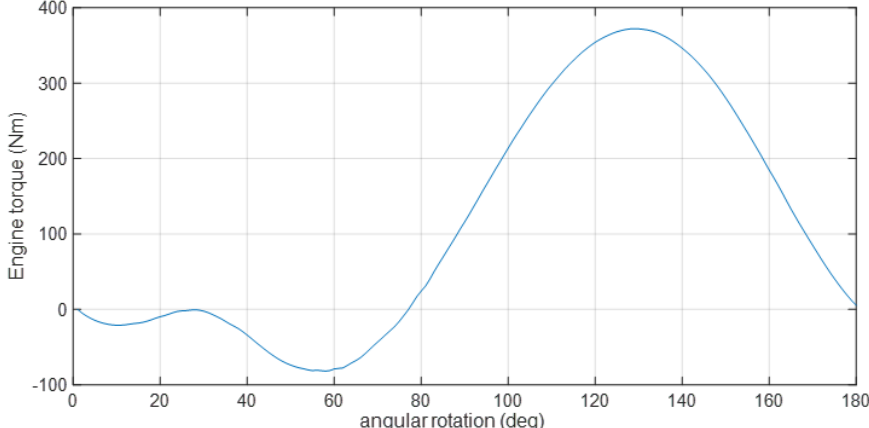
Figure 8. The experimental torque law of the I.C. Engine with four cylinders, four strokes.